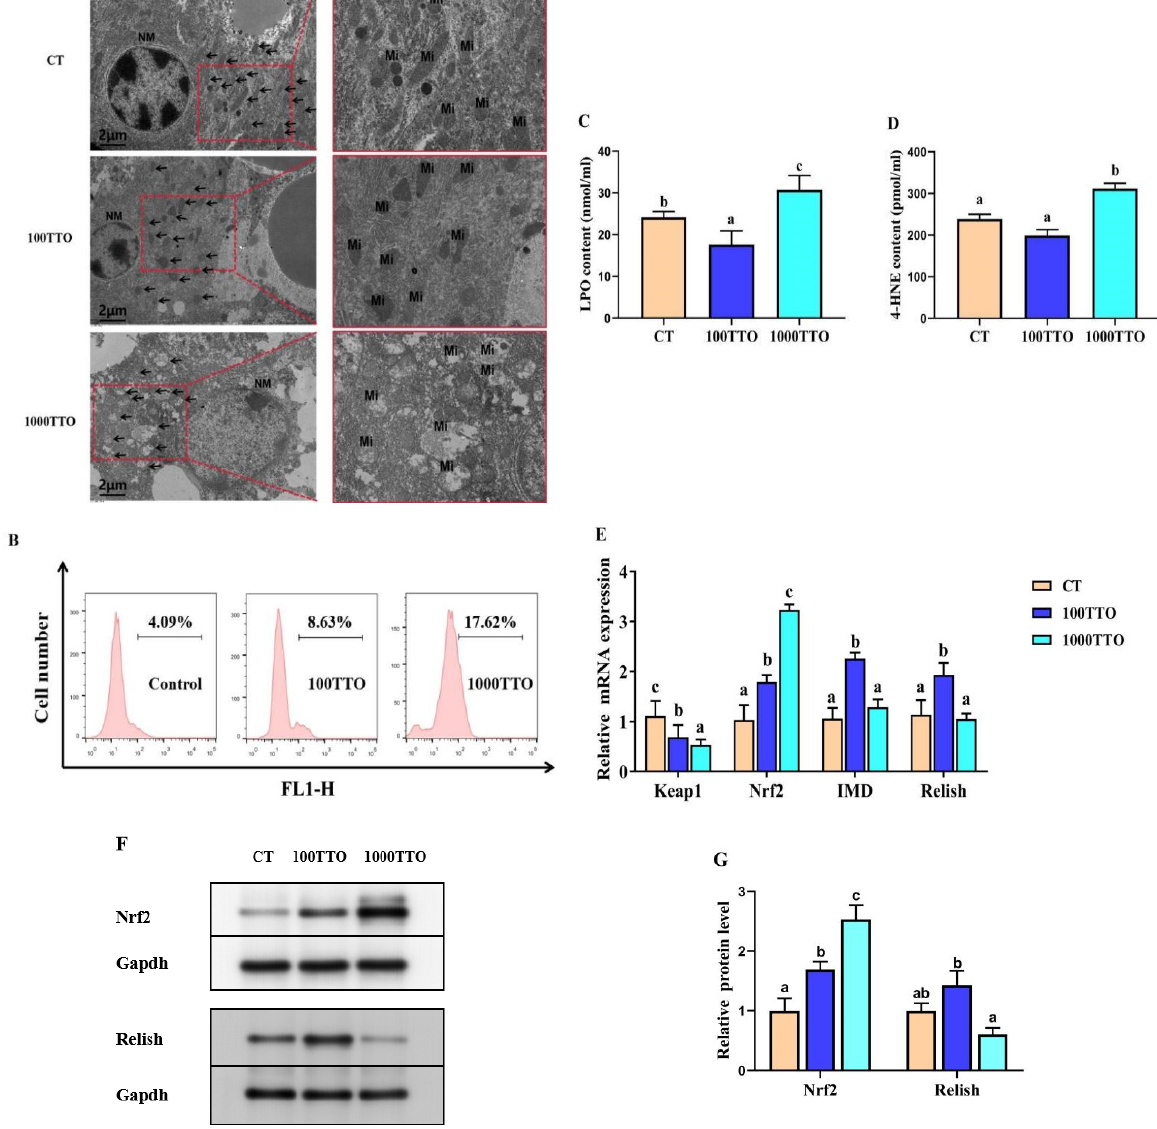
Figure 6. Effects of dietary TTO levels on hepatopancreatic oxidative stress of M. rosenbergii . ( A ) Characteristic TEM image. Arrow points to mitochondria; NM, nuclear membranes; Mi, mitochon ‐ dria. ( B ) Fluorescence intensity of ROS in hemolymph displayed by flow cytometry. ( C ) LPO con ‐ tent; ( D ) 4 ‐ HNE content. ( E ) mRNA levels of Keap1 , Nrf2 , Imd and Relish . ( F ) Nrf2 and Relish protein bands under Western blot analysis. ( G ) Relative quantification of Nrf2 and Relish protein expres ‐ sion. The significant difference between the three TTO levels is characterized by different lowercase letters (a, b, c) ( p < 0.05).